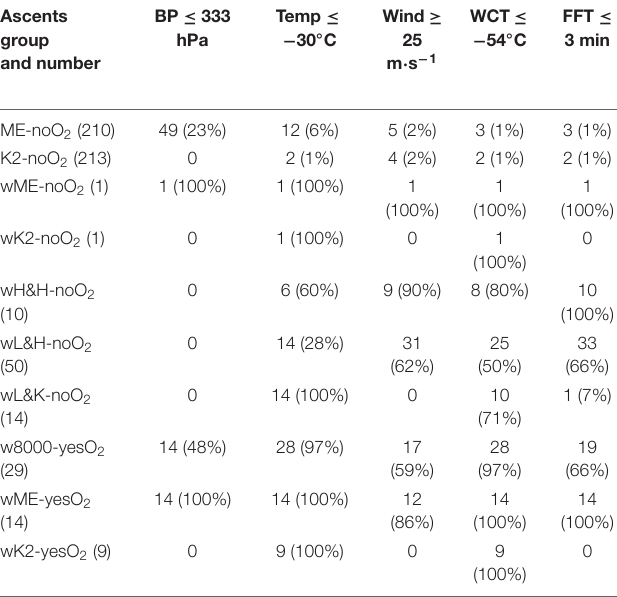
TABLE 2 | Number of ascents under the most severe environmental conditions of barometric pressure, ambient temperature, wind chill temperature and facial frostbite time within the 10th percentile and wind speed within 90th percentile for ascents without supplemental